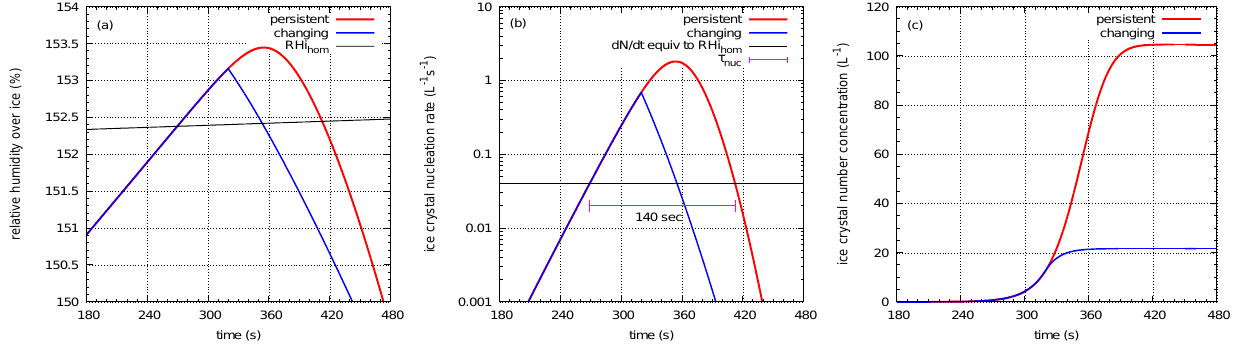
Fig. 1. Example of the impact of changing updraughts on the formation of ice crystals via homogeneous freezing of solution droplets. The three panels show the time evolution of (a) relative humidity with respect to ice, (b) ice crystal nucleation rate, and (c) ice crystal number concentration. Red curves indicate a constant persistent updraught of w = 0 . 1ms − 1 , whereas blue curves indicate a scenario with a constant updraught of w = 0 . 1ms − 1 until t = 320s, followed by a constant downdraught of w = − 0 . 1ms − 1 . The black line in panel (a) indicates the homogeneous nucleation threshold for solution droplets of size r = 0 . 25µm; this threshold corresponds to a production rate of d N i / d t = 0 . 04L − 1 s − 1 as indicated in panel (b)